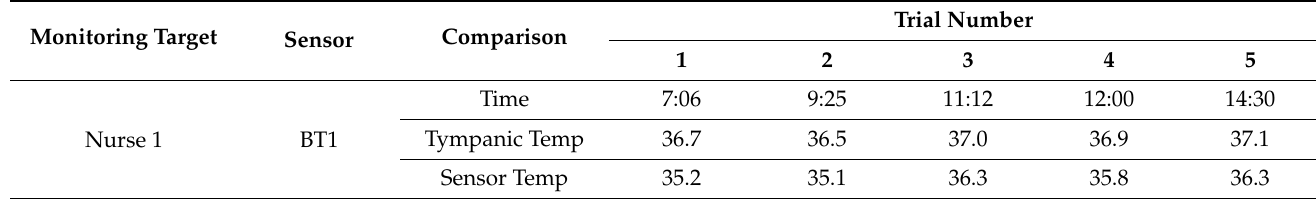
Table 9. Body Temperature Monitored of Nurses Using the Non-Hospital